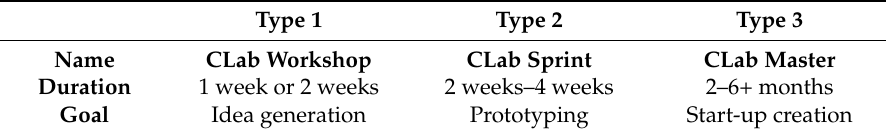
Table 1. Scheme of the type 1, 2 and 3 courses. CLab: contamination